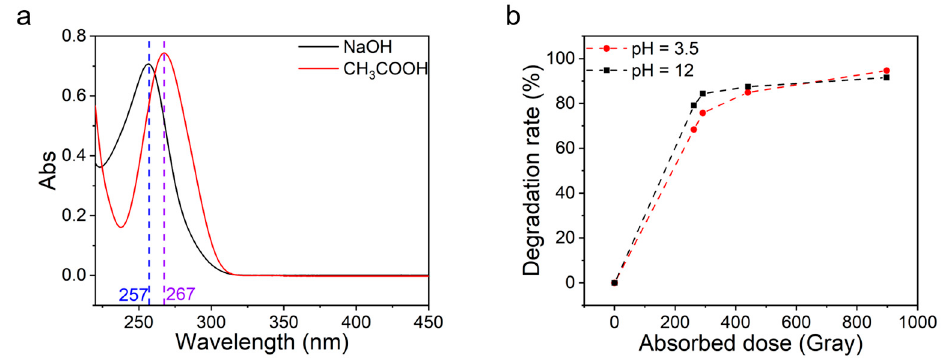
Figure 5. Effect of pH value of initial solution on degradation of SMZ: ( a ) Ultraviolet-visible spec- trogram of NaOH and CH 3 COOH; ( b ) degradation rate diagrams of SMZ (energy = 80 keV; beam current = 1 mA; initial SMZ = 10.70 mg/L).